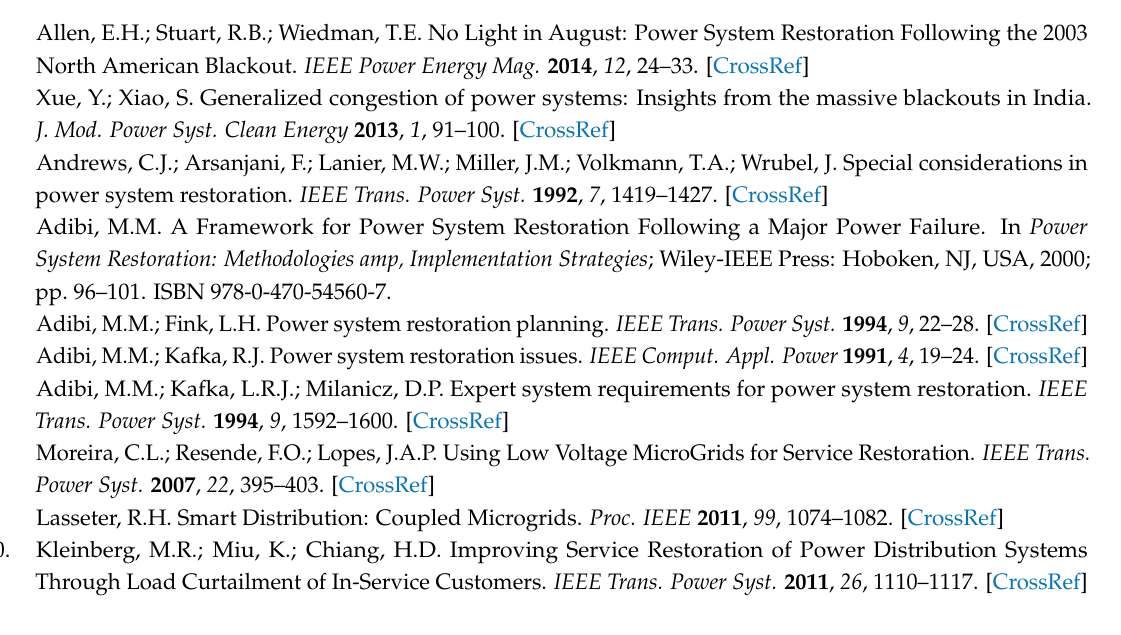
Figure 15. Real power of the microsources.